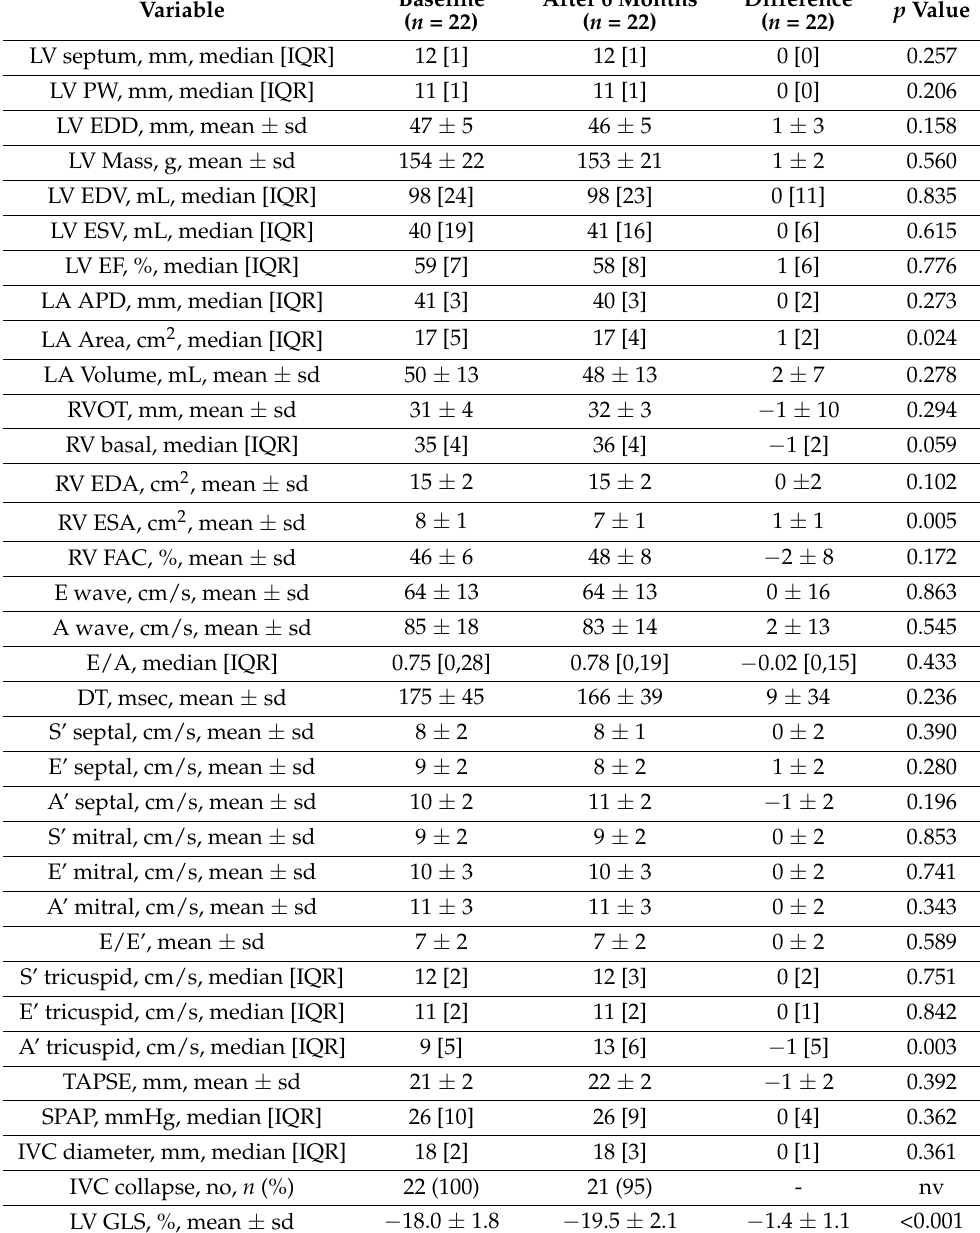
Table 2. Echocardiographic data at baseline and after 6 months of GLP-1RA treatment. LV: